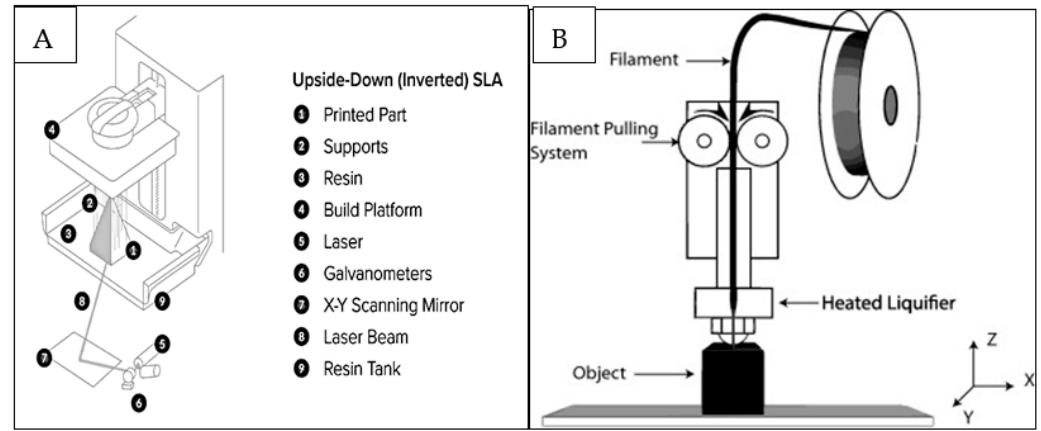
Figure 2. ( A ) Prototype representations of Stereolithography (SLA/SLG) 3D printing method, adapted from the dental.formlabs website [18] and ( B ) Fused deposition modelling (FDM) printing technique. Image reprinted with permission from Carneiro et al. [17].